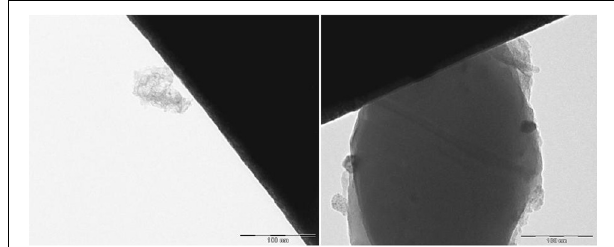
FIGURE 2 | EFTEM pictures of the catalyst containing palladium in a (ADBA)(MeO) on ACC as fresh (left) and after being exposed to citral hydrogenation reaction.